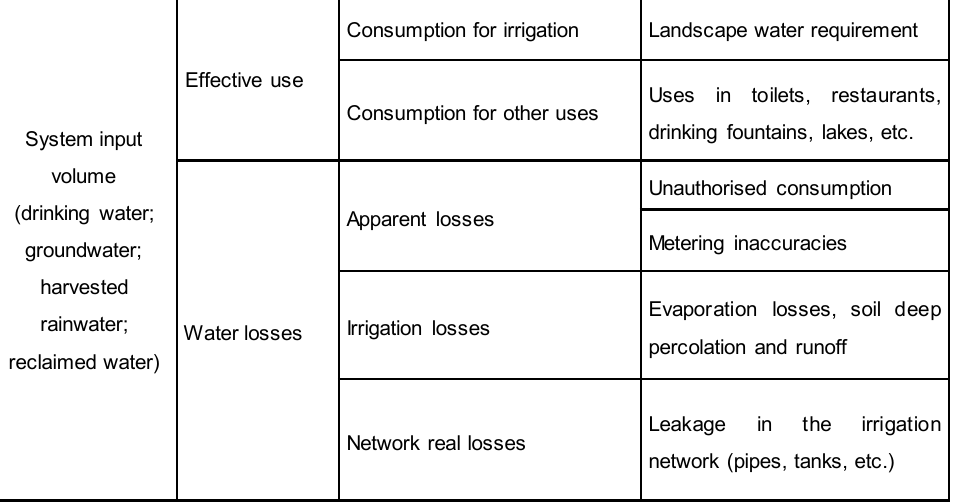
Figure 1. Proposed water balance for urban green spaces (m 3 /year).